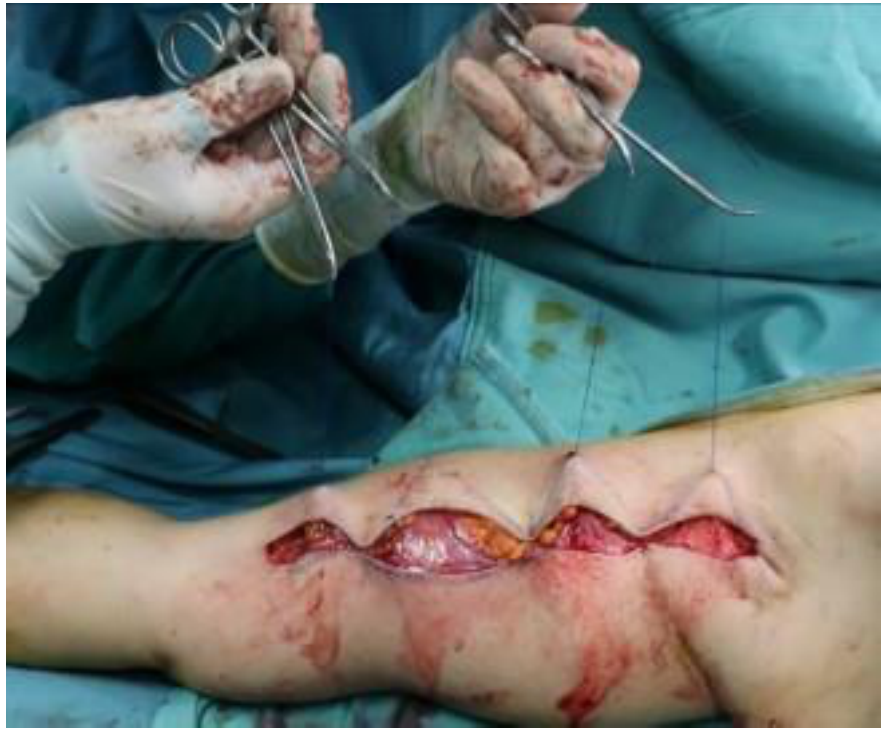
Figure 3. Fixation of dermal flaps with transfixed skin stitches.